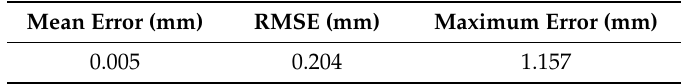
Table 4. Mean Error, RMSE and Maximum Error of the reconstructed